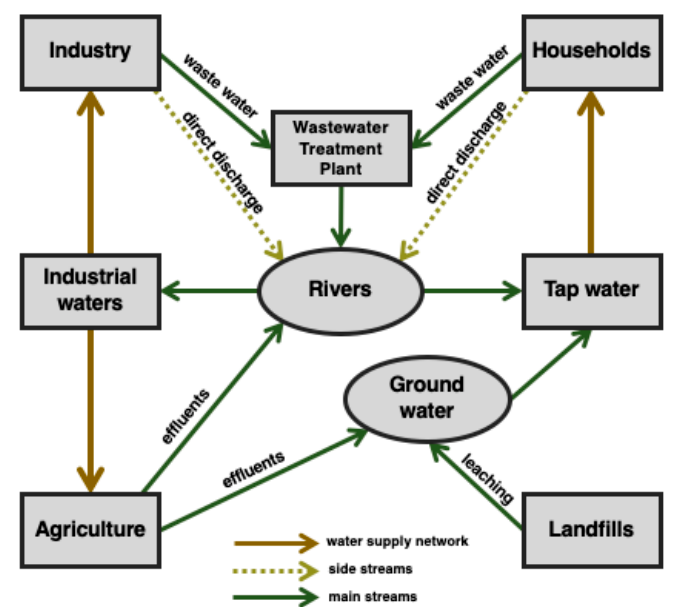
Figure 1. Sources of natural environment contamination with pharmaceuticals. Side and main streams indicate the relative amount of pharmaceutical contaminants introduced to the environment.